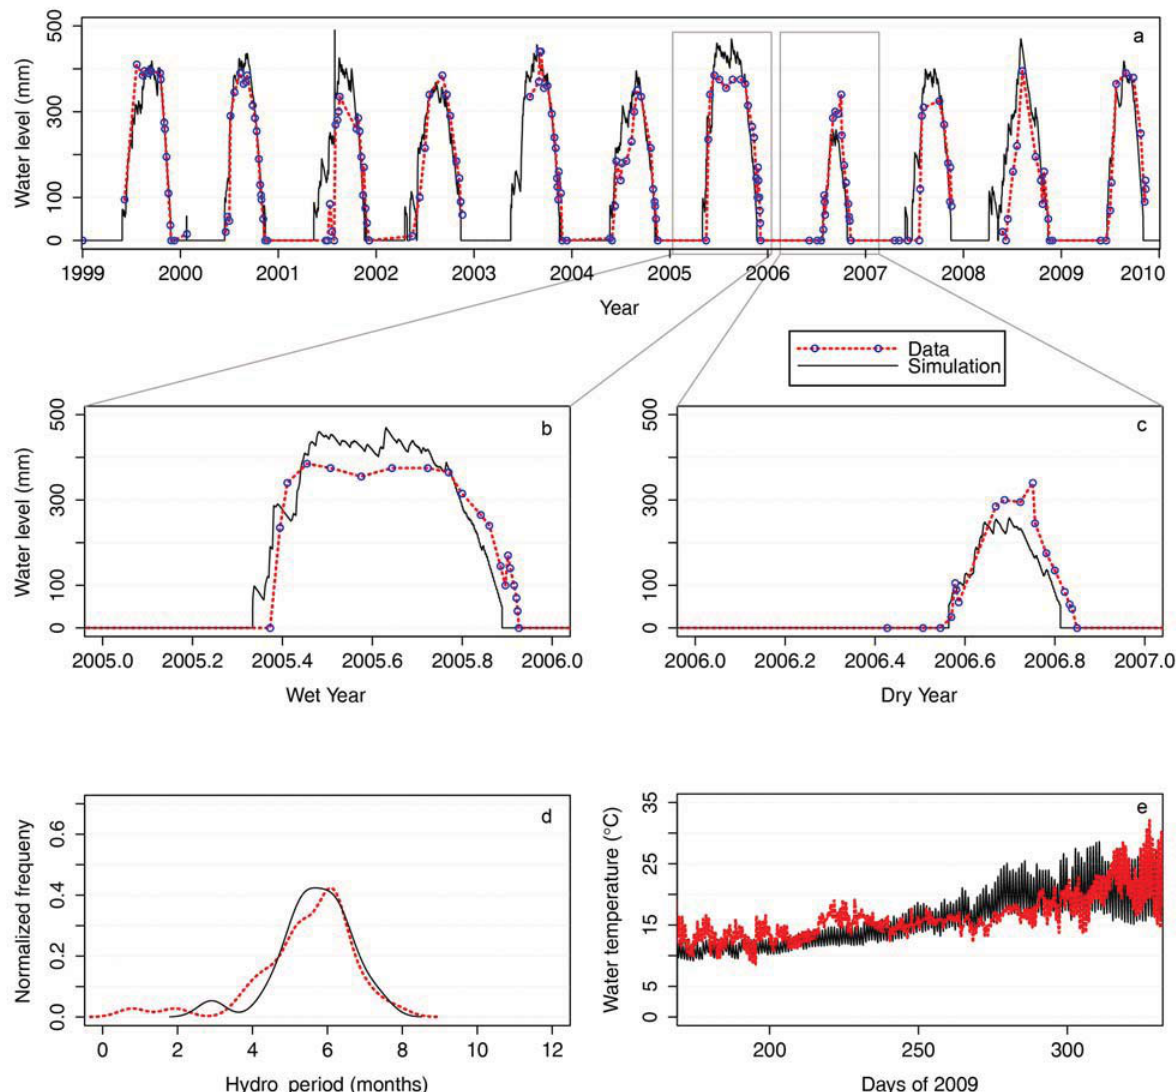
Figure 2. Time series of modeled (solid black line) and actual (red dotted line) hydroperiods and water temperatures at Ellen Brook Nature Reserve (EBNR). ( a ) water levels and hydroperiods of EBNR from the WET-R simulation from 1999 to 2009; ( b ) and ( c ) magnified views of water levels and hydroperiods for a wet (2005–2006) and dry (2006–2007) year; ( d ) normalized frequency of actual and simulated hydro periods (months) over 1999–2009; ( e ) actual and simulated water temperature during the 2009 hydroperiod (days